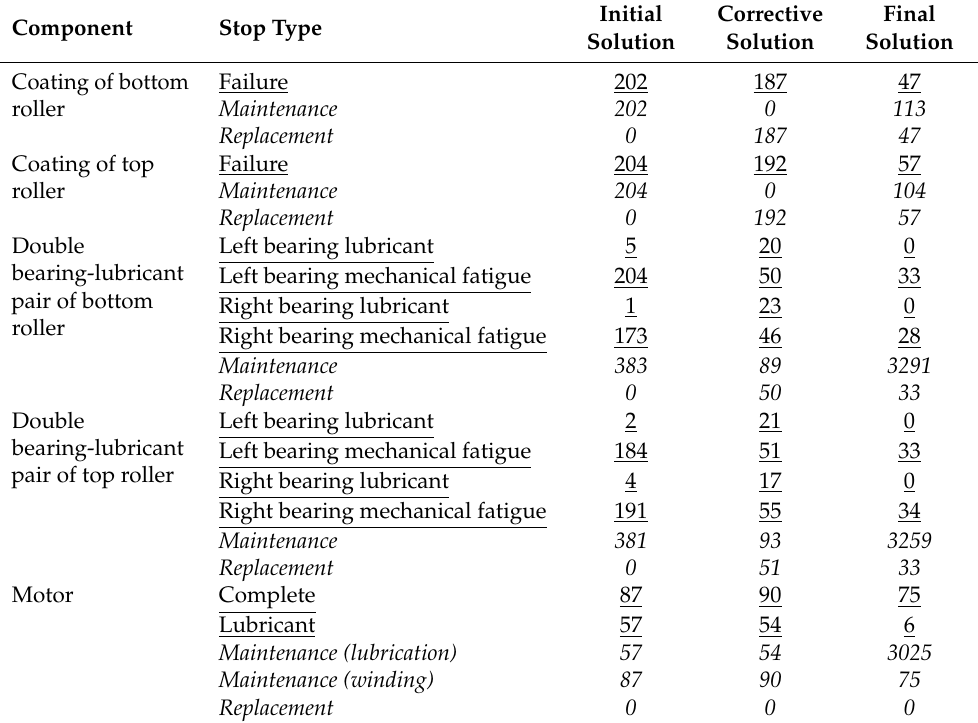
Table 22. Numbers of stop instances yielded from training the model with paired coated rollers for the bleaching machine (ZORLUTEKS) within the simulation interval (200 years). Underlined and italic contents correspond to failures and strategies,